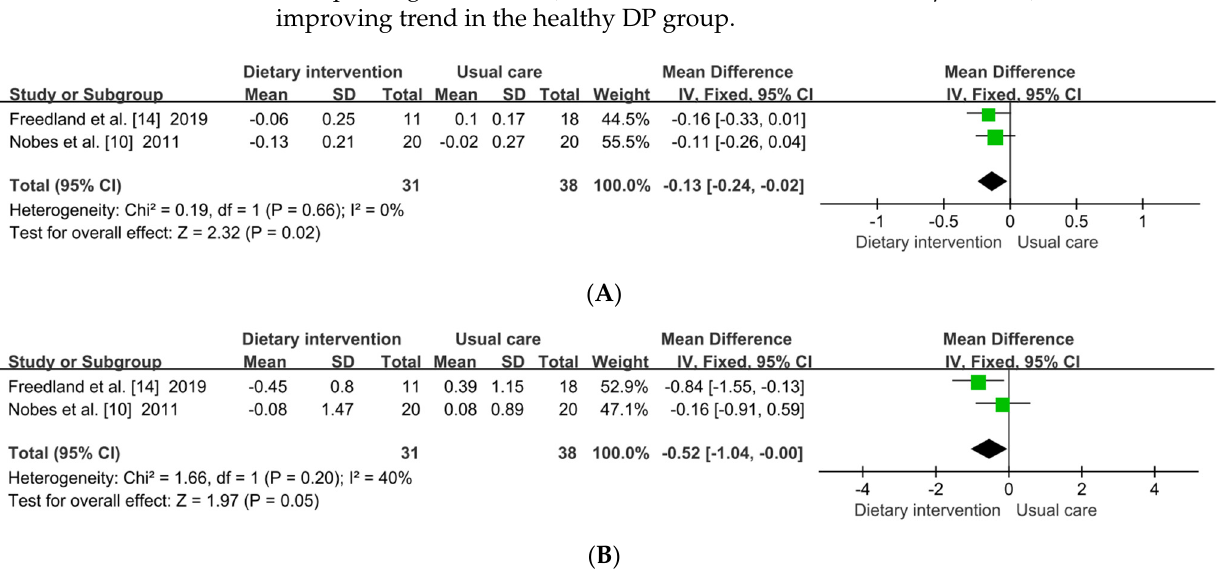
Figure 3. Forest plot of effect of healthy DP on glucose metabolism. DP, dietary pattern; HbAlc, glycated hemoglobin; HOMA-IR, homeostasis model assessment of insulin resistance; the diamond, effect size and 95%CIs; green color, weight. ( A ) HbA1c and ( B ) HOMA-IR.